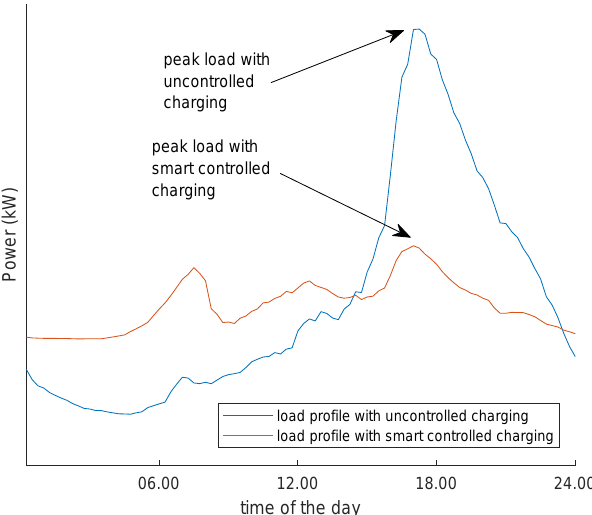
Figure 5. Schematic outline of daily load profiles with and without shifting EV charging load in time. The arrows point out peak loads. The difference between the pointed out peak loads is the amount of peak power